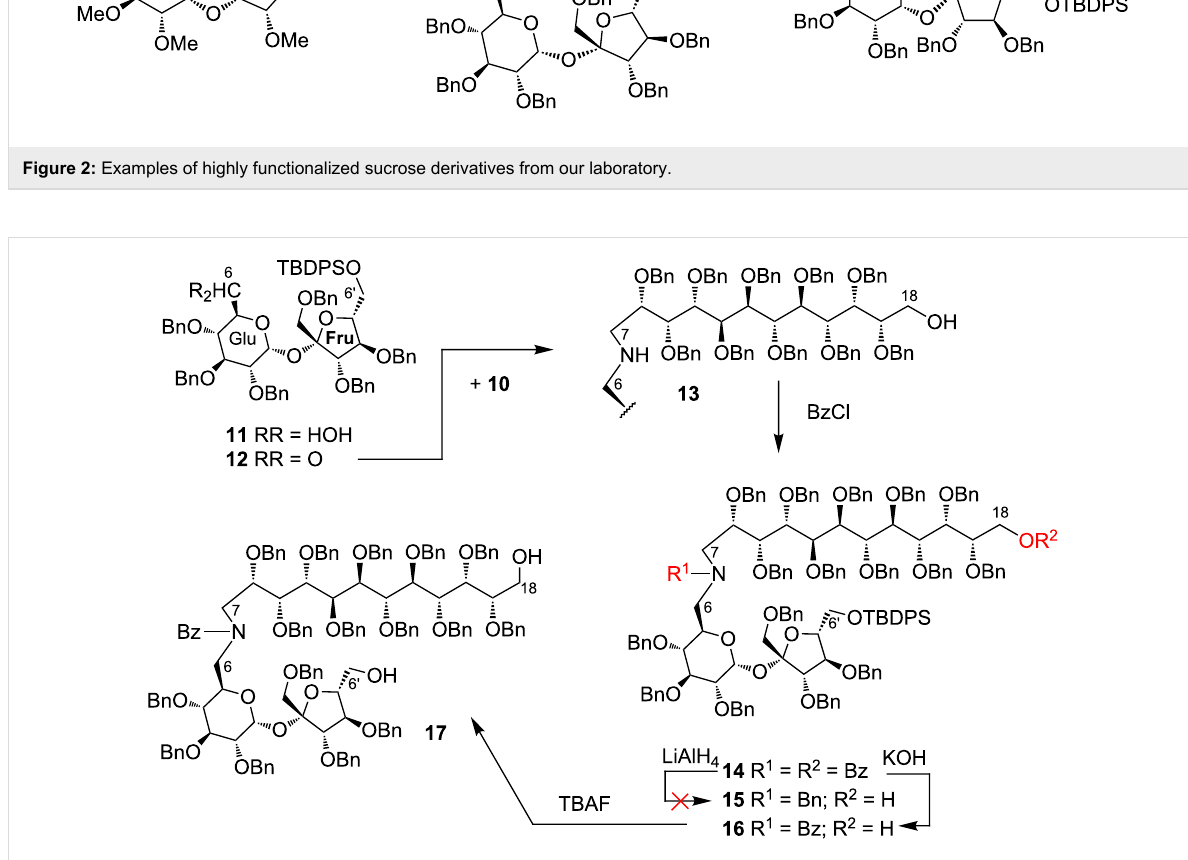
Scheme 2: Preparation of a sucrose molecule with a higher aminoalditol